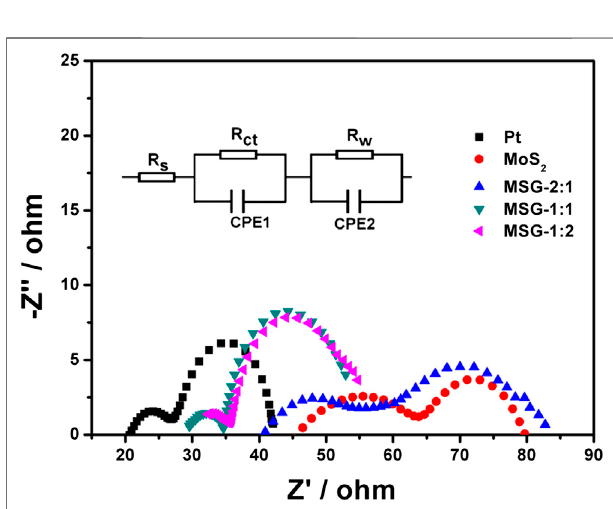
FIGURE 5 | EIS of DSSCs with MSG-2:1, MSG-1:1, MSG-1:2, MoS 2 , and Ptcounter electrodes. Insetdisplaysthecorrespondingequivalent circuit.